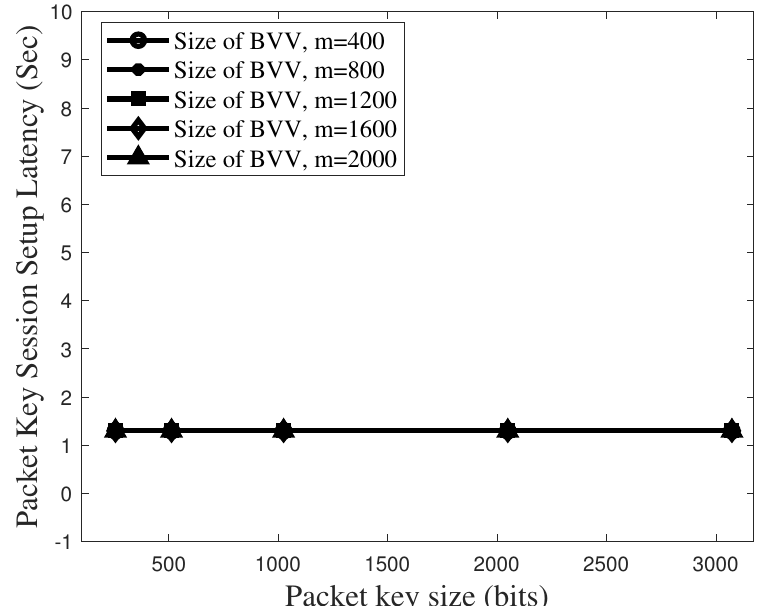
Figure 15. Total latency to set up a packet key-based secure session in the non-scalable BSM model. Figure 16 plots the total latency to set up the packet key-based secure session in the vertical model,